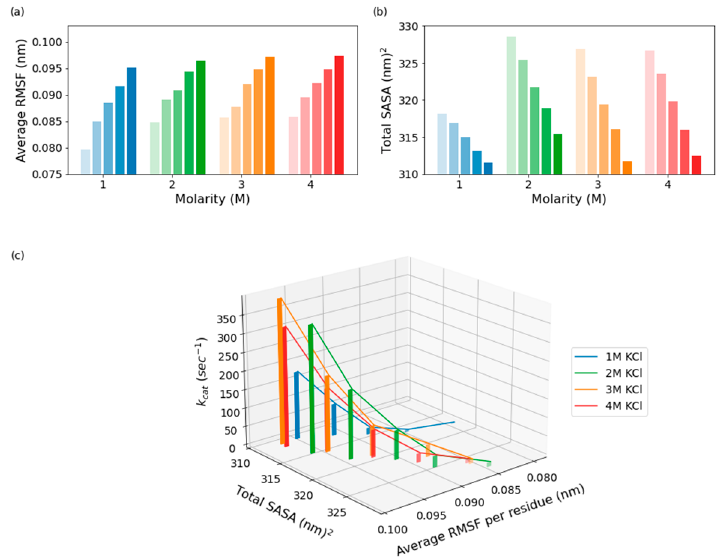
Figure 6. Average RMSF per residue ( a ), total SASA ( b ), and SASA vs. RMSF vs. k cat ( c ) for five temperatures, ranging from 10 °C to 50 °C, the color of the bars becoming more saturated at the higher temperatures, and the four molarities.